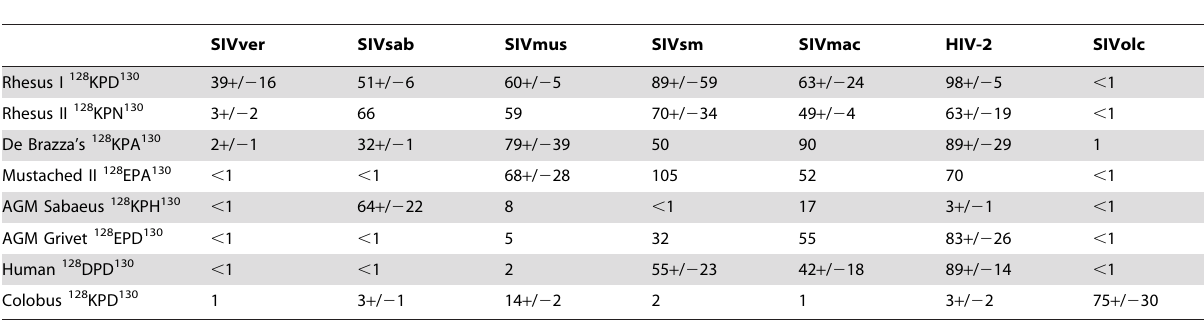
Table 1. Sensitivity of A3G variants to a spectrum of diverse SIV Vif